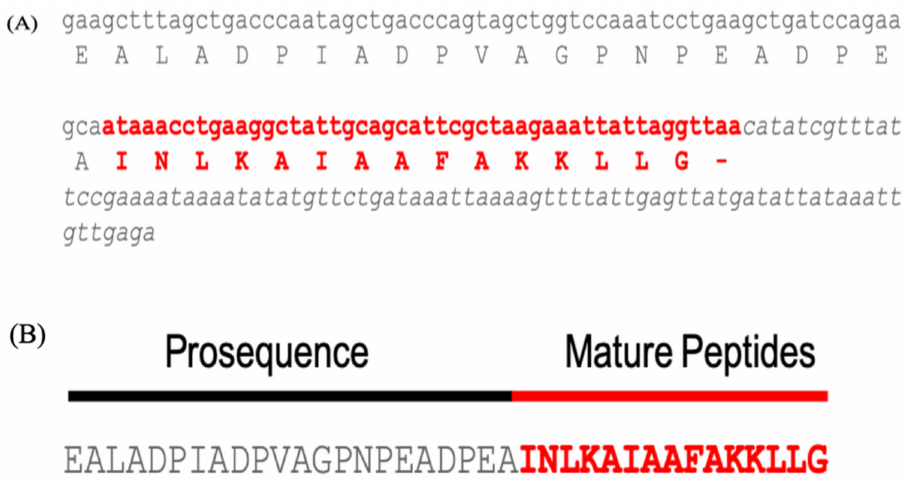
Figure 1. The partial nucleotide sequence and deduced amino acid sequence of V. tropica mastoparans (MpVT): ( A ) The nucleotide sequence of MpVT. The stop codon of the sequences marks as -. The mature sequences are shown in red letters and italic type, which were obtained by Edman degradation. ( B ) The deduced MpVT amino acid sequences of prosequences and mature